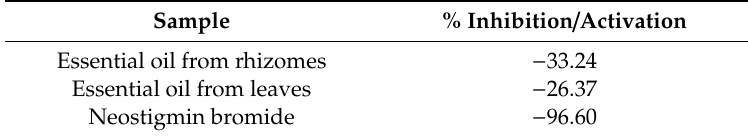
Anti-cholinesterase activity of essential oils obtained from rhizome and leaves of P. hybridus subsp.